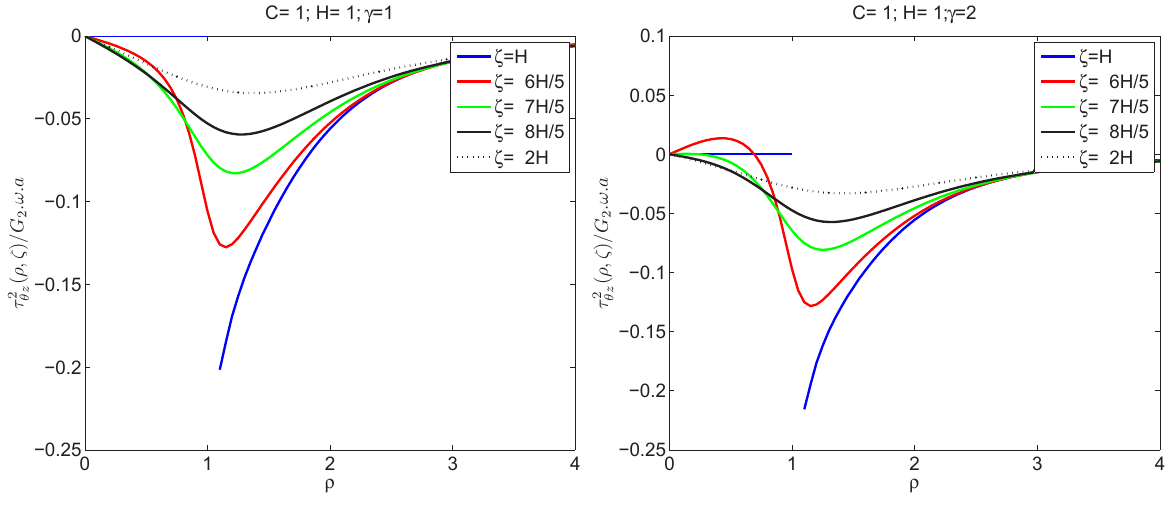
Figure 8: Shear stress τ θz2 versus ρ for various ξ,